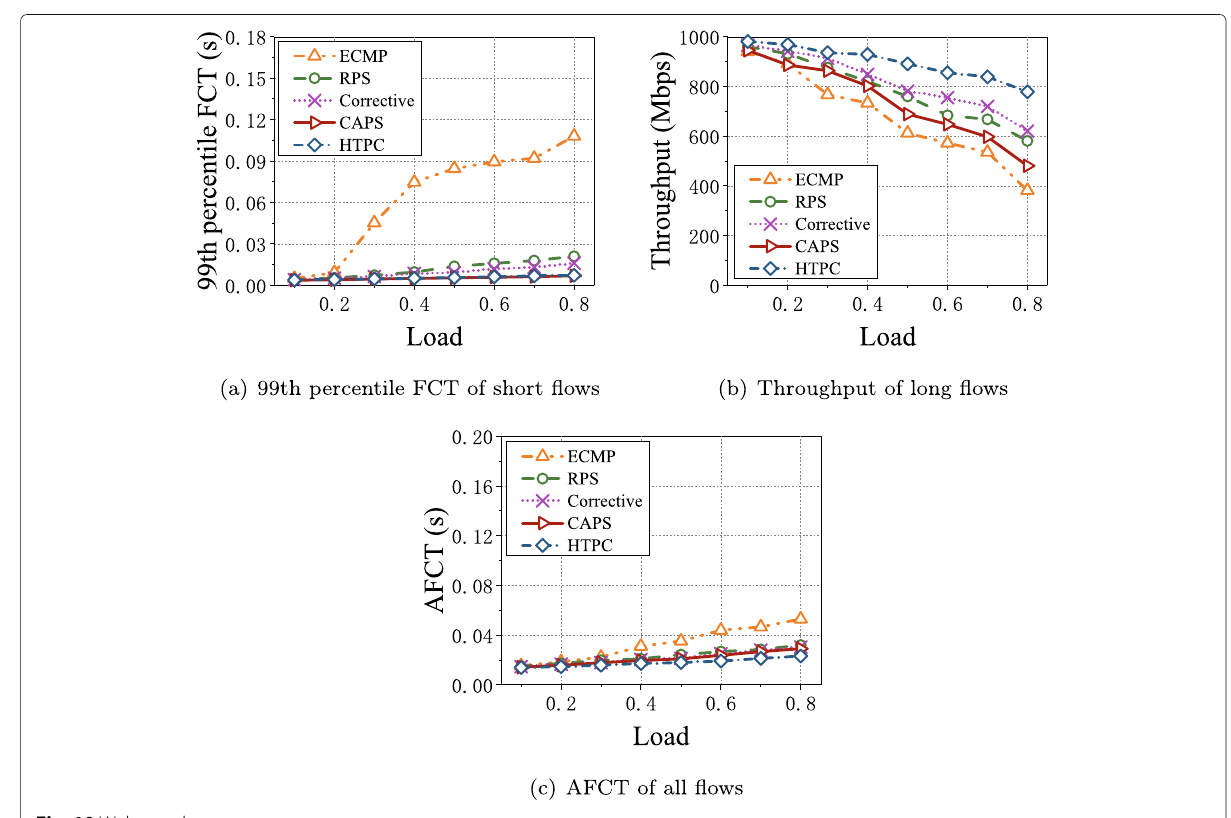
Performance under asymmetric topology and different network